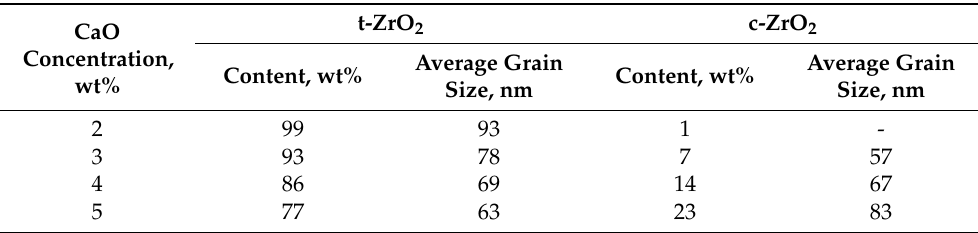
Figure 4. The dependence of hardness of the CaO-ZrO 2 ceramic sintered at 1300 ° С containing a different CaO amount on the inversed square root of the effective grain size. The dots are connected by lines for clarity. Table 2. The content of t-ZrO 2 and c-ZrO 2 phases and the average grain size of t-ZrO 2 and c-ZrO 2 phases in CaO-ZrO 2 ceramic sintered at 1300 ° С containing a different CaO amount.